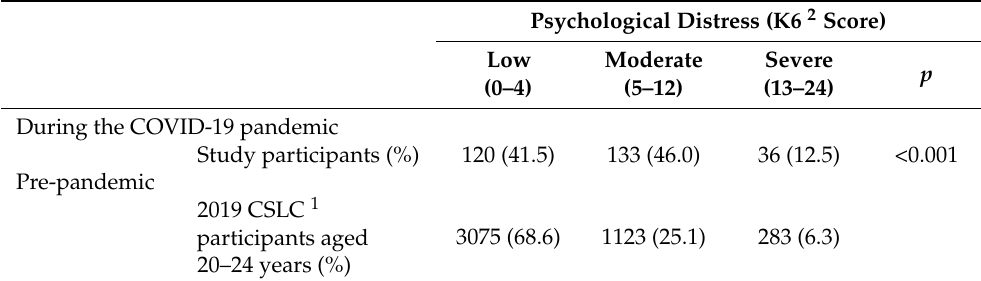
Table 2. Comparison of psychological distress levels between study participants and the 2019 CSLC participants ( n = 289).